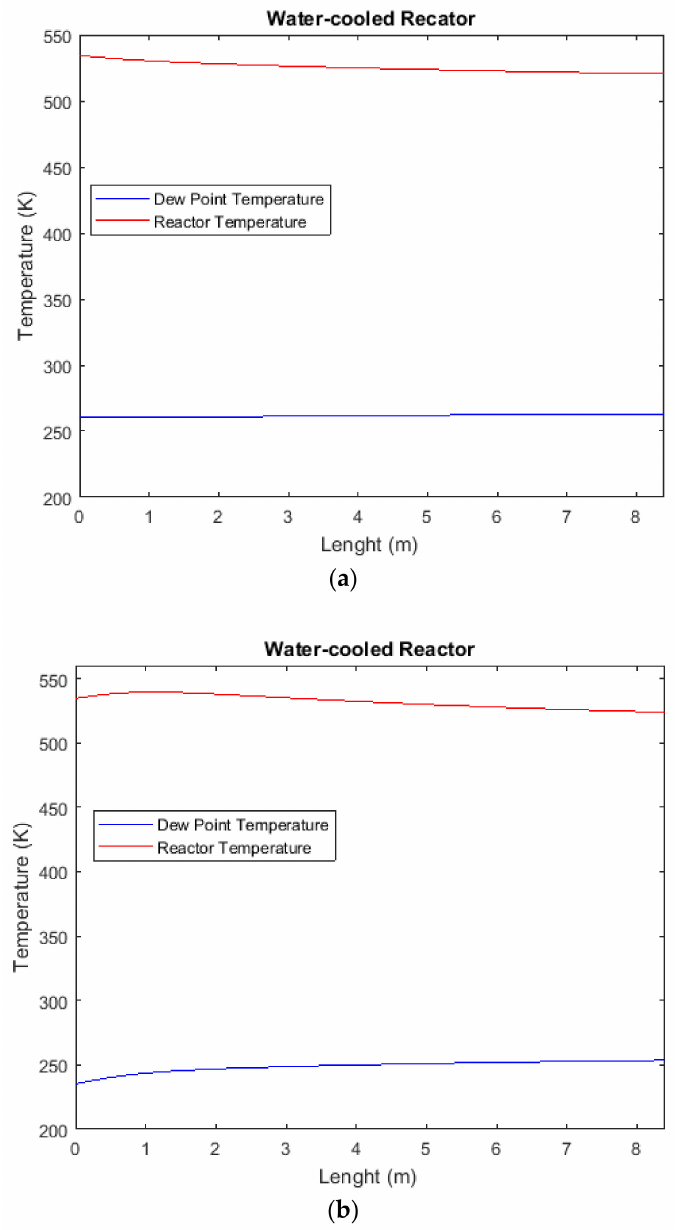
Figure 3. Comparison between temperature profile and dew point temperature along the water-cooled reactor in ( a ) AW configuration; and ( b ) ACW